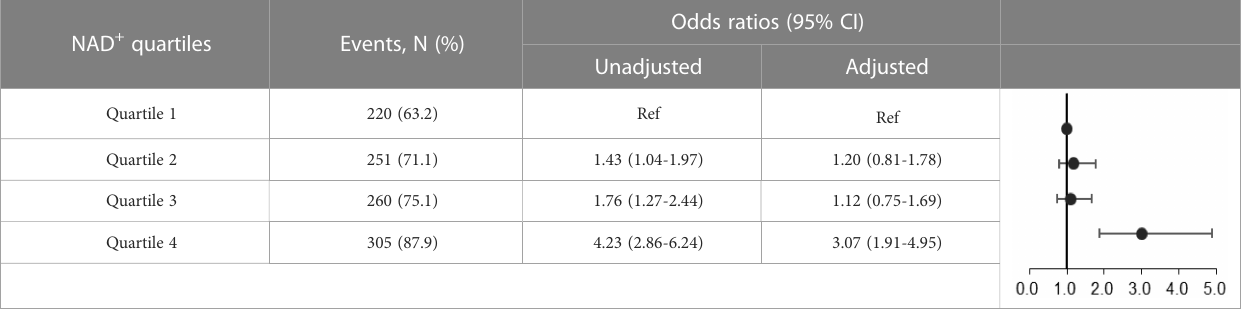
TABLE 2 Association of NAD + levels with metabolic disease in the whole population.